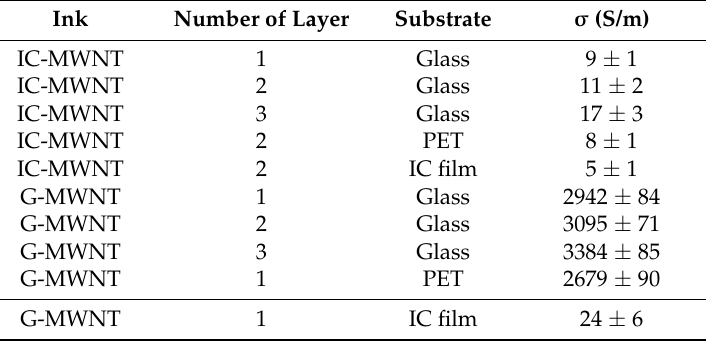
Table 2. Summary of electrical conductivity ( σ ) values of IC-MWNT and G-MWNT composite inks extruded on various substrates (glass, PET, and IC film).